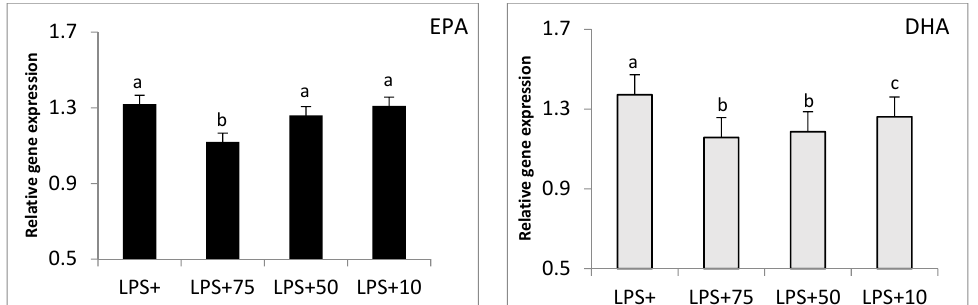
Figure 6. Changes in TNFA and IL6 gene expression at different n -3 FAs concentrations were assessed using real-time PCR. PCR samples were normalized against 18S gene expression. Superscripts represent significant differences ( p ≤ 0.05) between each concentration.